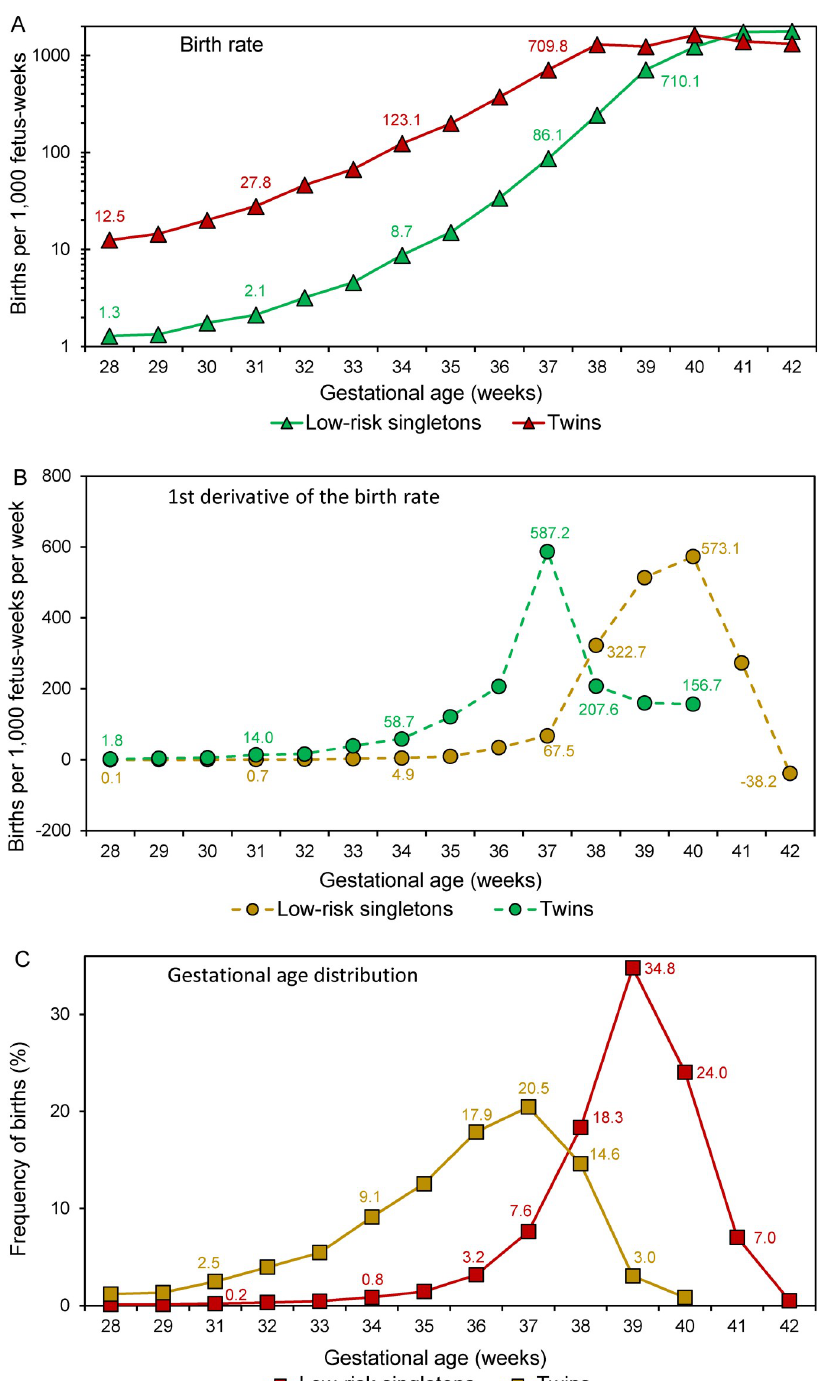
Fig 2. Gestational age-specific birth rates among singletons of low-risk women (i.e., without hypertension or diabetes) and twins (Panel A), the first derivative of the birth rate among singletons of low-risk women and twins (Panel B) and gestational age distributions (Panel C) among singletons of low-risk women and twins, United States, 2004–2015.